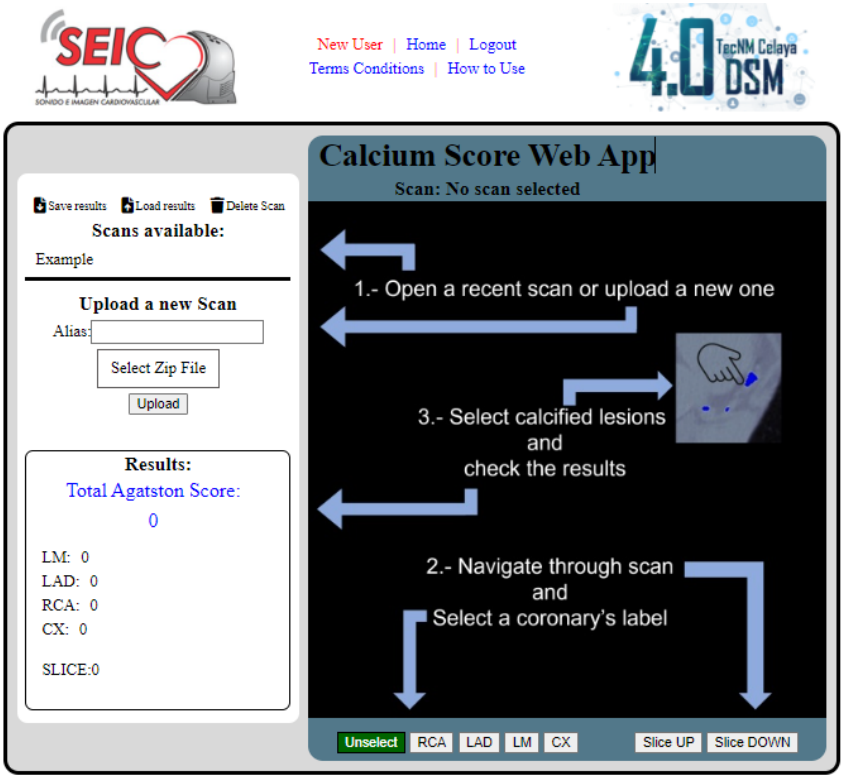
Figure 10. Home page with no scan